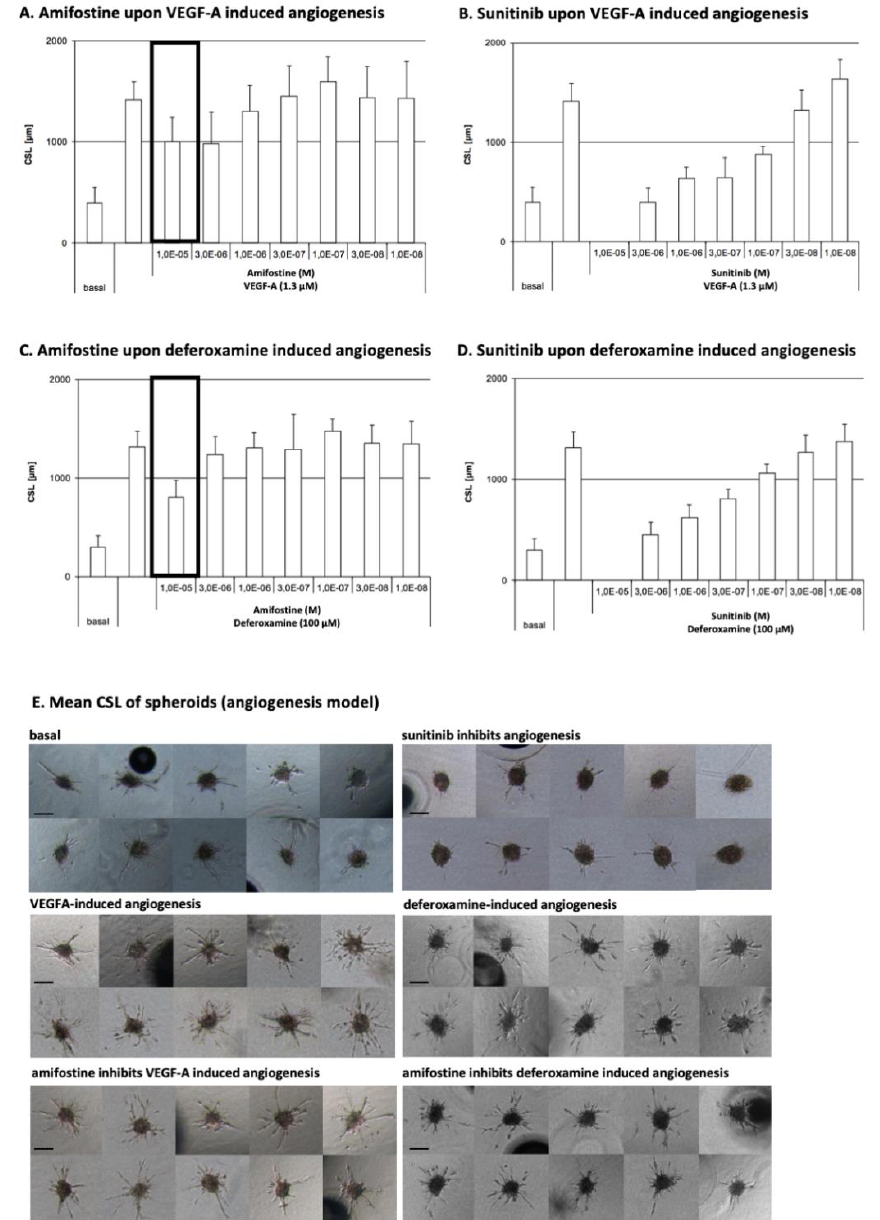
Figure 2. Amifostine effects on VEGF-A- or deferoxamine-induced angiogenesis. ( A ) Amifostine effects on VEGF-A-induced spheroid sprouting; ( B ) sunitinib effects on VEGF-A-induced spheroid sprouting; ( C ) amifostine effects on deferoxamine-induced spheroid sprouting; ( D ) sunitinib effects on deferoxamine-induced spheroid sprouting; ( E ) mean CSL of spheroids ( A – D , mean values and SD of CSL of 10 randomly selected spheroids per data point are depicted; 10 × objective magnification, digital imaging software Cell-Olympus, Hamburg, Germany). Drug-dependent alterations in the sprouting intensity were ranked from zero (0, no or strongly reduced sprouting activity compared with baseline) to triple cross (+++, enhanced sprouting activity compared with baseline). Herein, sunitinib corresponds to zero (0) and amifostine to inhibition (+).